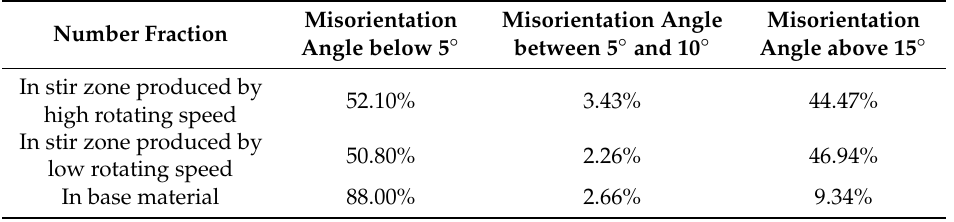
Table 2. Comparison of number fraction of misorientation angle in stir zone and base material.